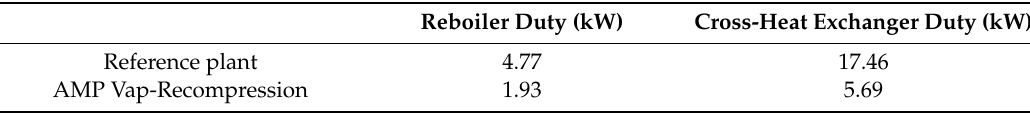
Table 6. Results for vapor recompression.